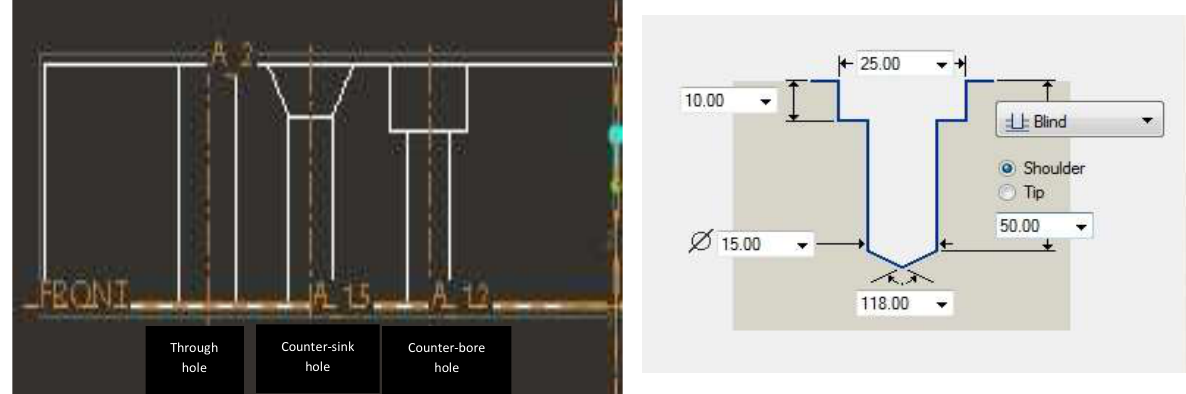
Fig.1. Drawing of different types of holes Fig.2. Anatomy of a counter-bore hole